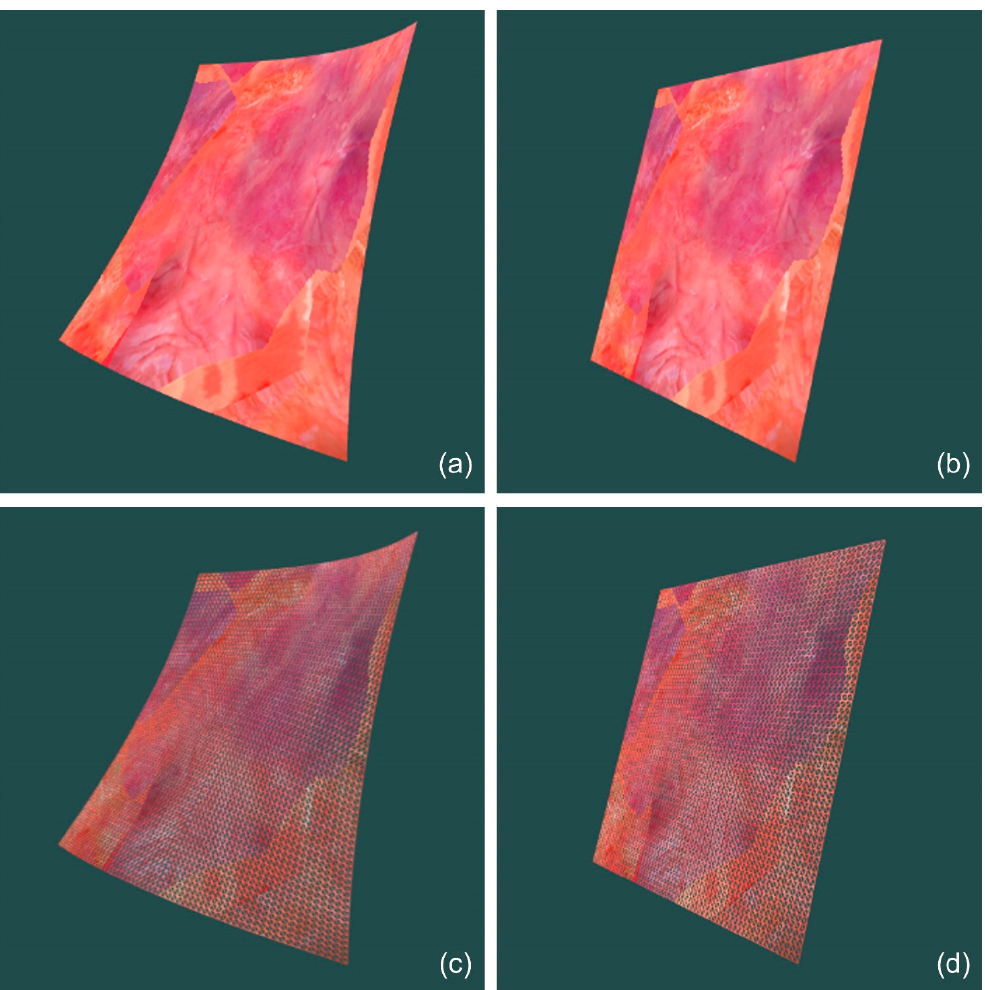
Figure 11. Model rendering after a superposition: ( a ) superimposing the front effect, ( b ) effect after a superposition, ( c ) point effect before stacking, and ( d ) point effect after stacking.